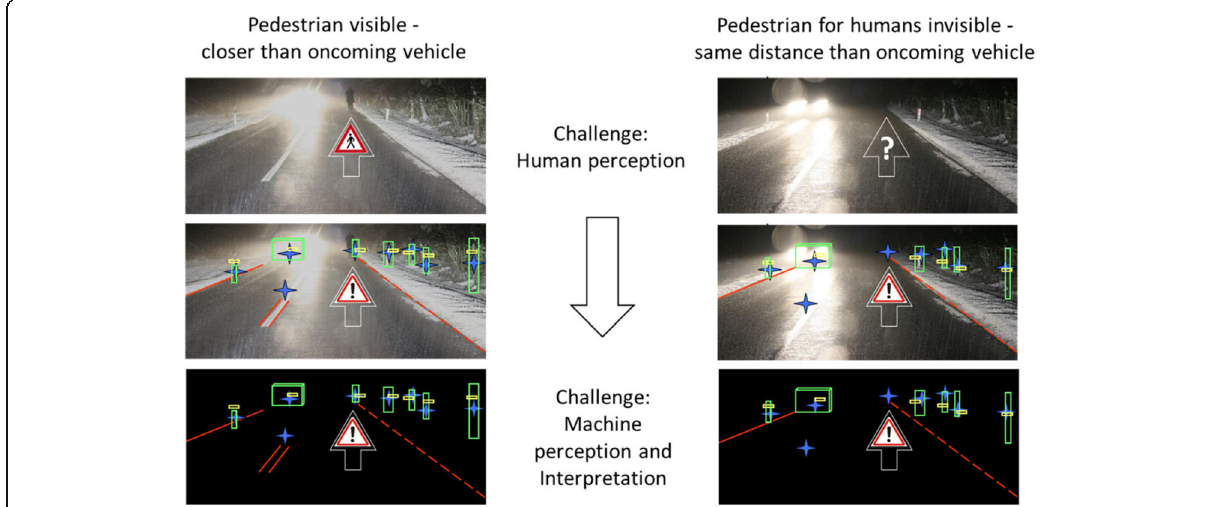
Fig. 6 Example of a fatal pedestrian accident in Saxony: Challenge of human and machine perception of a pedestrian. Left side: Pedestrian is visible in the light beam and closer than the oncoming vehicle. Right side: Pedestrian is invisible out of the light beam for human perception when distance is greater than oncoming vehicle lights (upper images: driving scene with human perception, center images: overlay human with machine perception. Radar in blue with Lidar in yellow, camera detection in red and green. Lower images: driving scene with machine perception and interpretation)